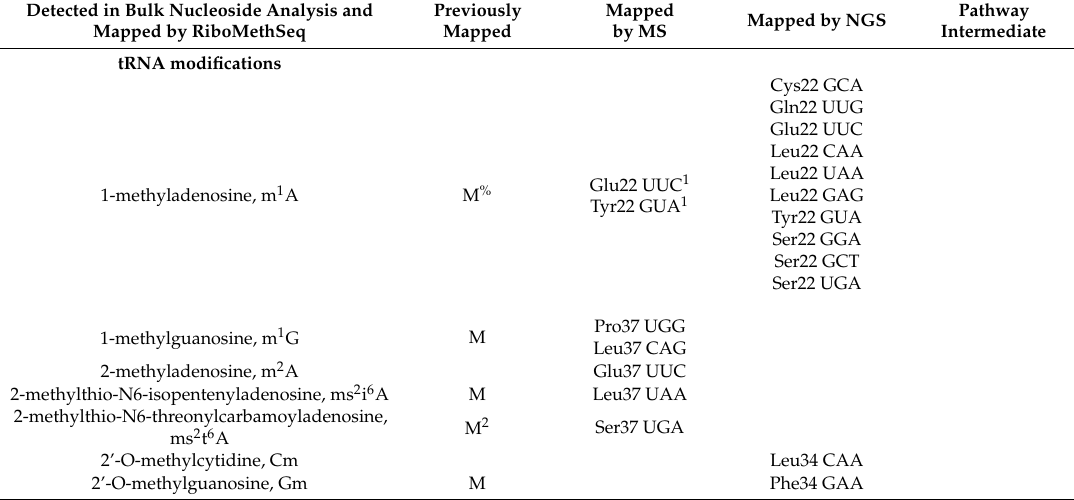
Table 1. Modified ribonucleosides identified in B. subtilis